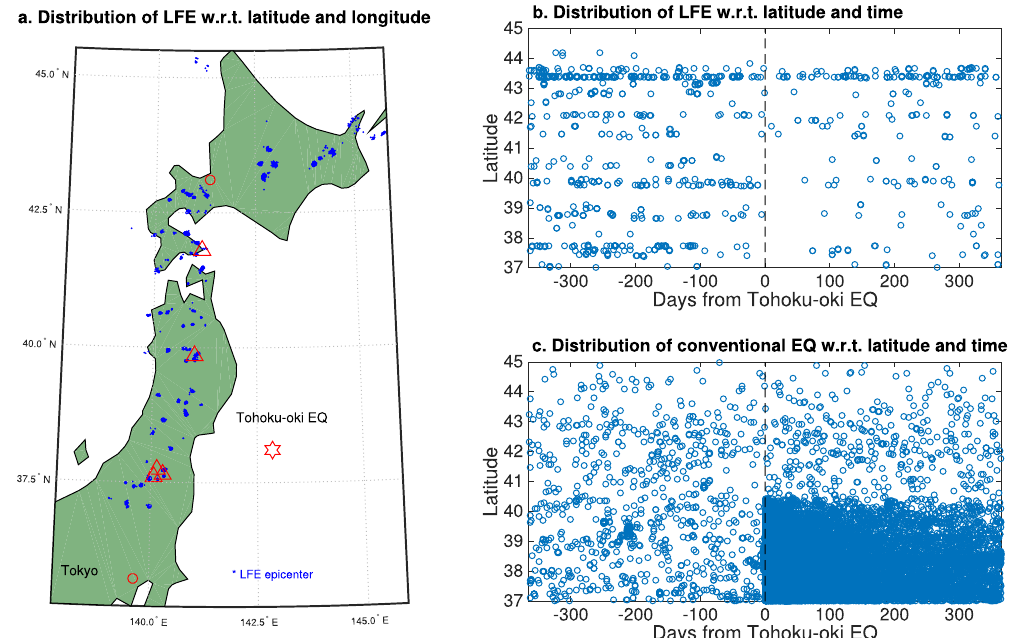
Figure 1. Distribution of LFE and conventional EQ. Panel a. Latitude and longitude distribution. Locations of epicenters of LFE (blue dots) and five volcanoes (triangles): Esan, Iwatesan, Azumayama, Adatarayama, and Bandaisan from North to South. The red hexagram denotes the epicenter of the Tohoku-oki EQ. Panel b. Latitude and temporal distribution of LFE. Panel c. Latitude and temporal distribution of conventional EQ with magnitude greater or equal to three. An apparent onset of large seismicity in conventional EQ just before the Tohoku-oki EQ is due to the occurrence of the foreshock with M w = 7.3 near the epicenter of the Tohoku- oki EQ two days before. In all panels, we focused on earthquakes in latitudes between 37°N and 45°N, and in longitudes between 139°E and